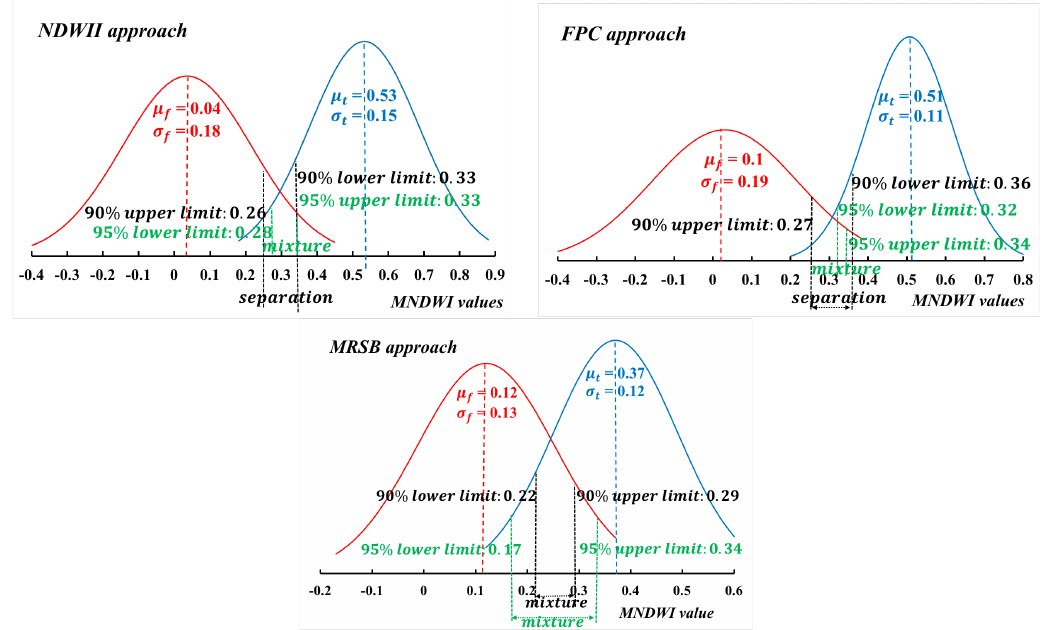
Figure 7. The theoretical separation between water and non-water areas. The blue and red normal distribution represents the water indices image values of water pixels and non-water pixels.